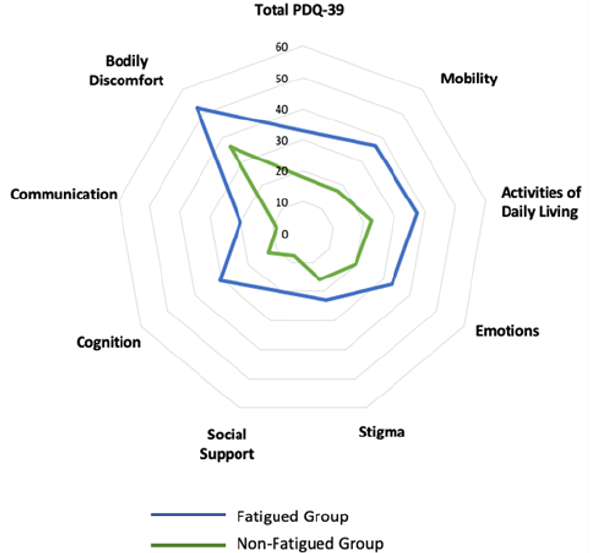
Figure 1. Total Parkinson Disease Questionnaire-39 and domain comparison between fatigued and non-fatigued patients.